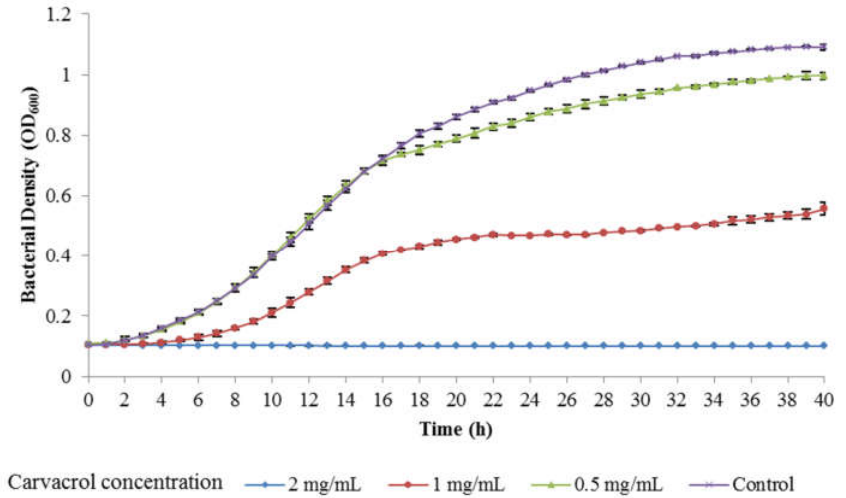
Figure 3. Growth inhibition of Psa (SCJY02-1) by carvacrol at different concentrations (0.5 mg/mL, 1 mg/mL and 2 mg/mL). Psa without carvacrol was used as control. Data are the mean ± standard deviation of three independent assays.